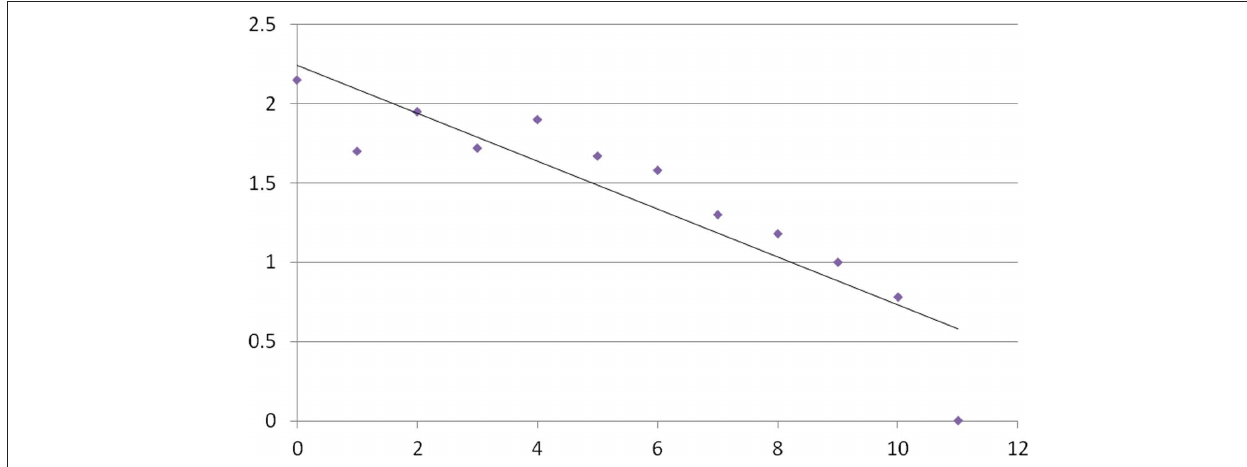
Figure 3 | Number of transitions ( x -axis) by log